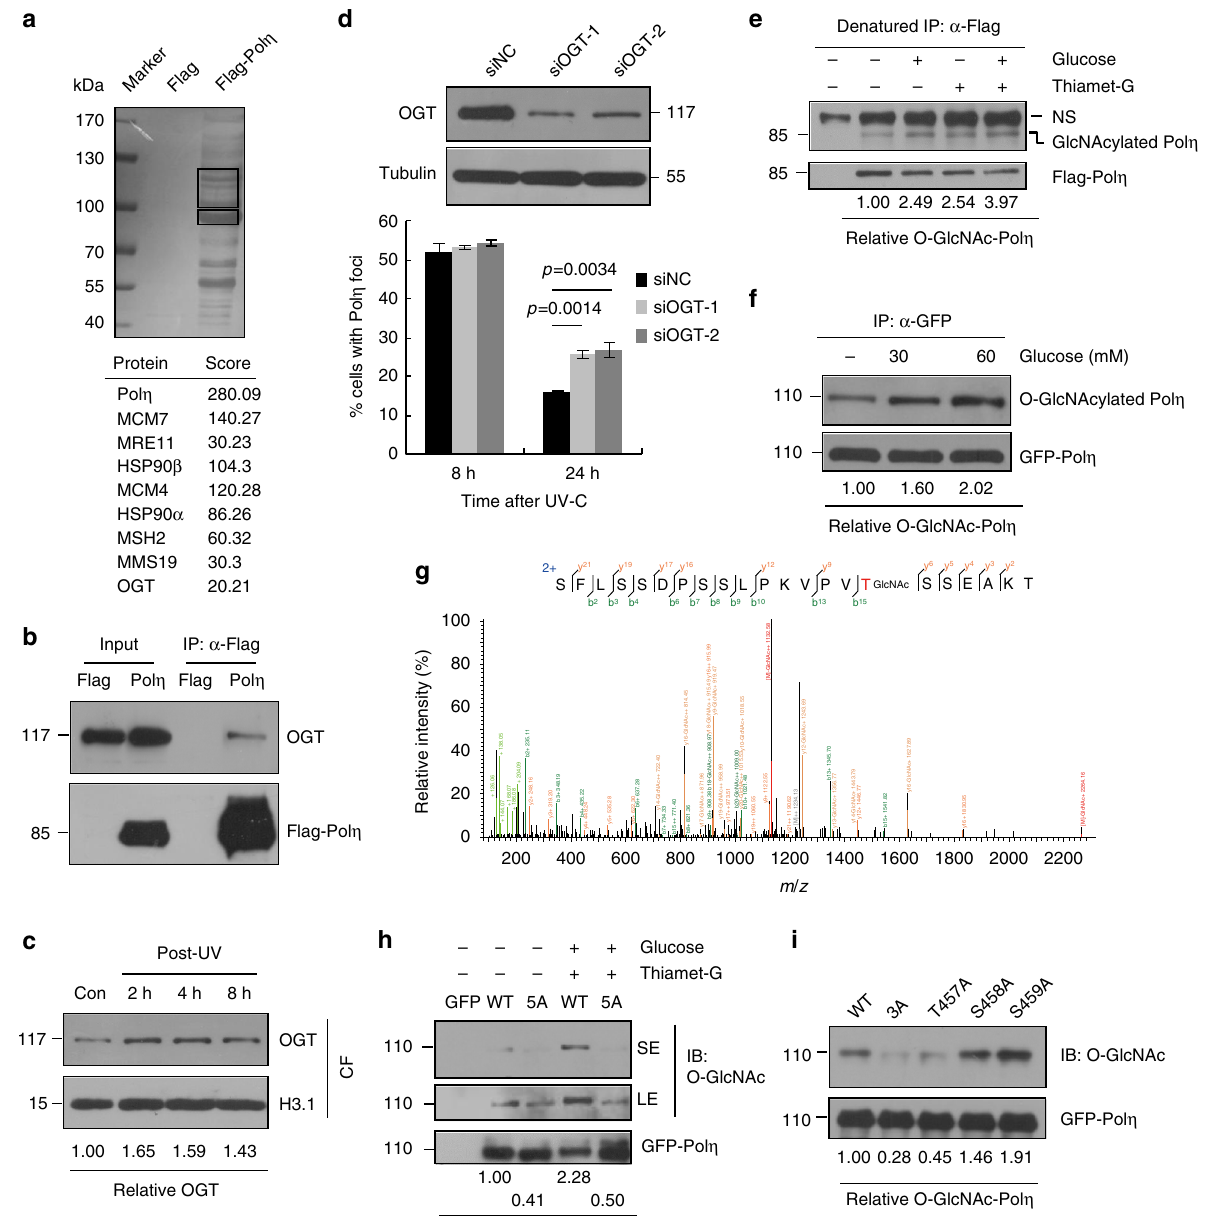
Fig. 1 Pol η interacts with OGT and is subject to O-GlcNAcylation predominantly at T457. a The nuclear extracts of 293T cells expressing Flag-Pol η were immunoprecipitated. The indicated bands (black rectangles) were cut and analyzed via mass spectrometric analysis. b 293T cell lysates expressing Flag-Pol η were immunoprecipitated and detected with anti-OGT and anti-Flag antibodies. The input included 2% of the cell lysate used. c U2OS cells were irradiated with UVC (15 J m − 2 ) and harvested at different time points later. The chromatin fractions were extracted followed by immunoblotting with OGT and H3.1 antibodies. d U2OS cells were transfected with siOGT or siNC oligos. The OGT protein level was detected by western blot. The knockdown cells were transfected with GFP-Pol η , irradiated with UVC (15 J m − 2 ) and further incubated for 24 h. The proportions of GFP-Pol η -expressing cells with > 30 foci were determined. Data represent means ± SEM from three independent experiments. e 293T cells transfected with Flag-Pol η or empty vector were incubated with Thiamet-G and glucose. The cell lysates were denatured and immunoprecipitated with anti-Flag M2 beads followed by immunoblotting with O-GlcNAc and Flag antibodies. NS: non-speci fi c band. f 293T cells transfected with GFP-Pol η were treated with Thiamet-G and different concentrations of glucose. The cell lysates were immunoprecipitated with GFP-Trap A followed by immunoblotting with O-GlcNAc and GFP antibodies. g 293T cells transfected with Flag-Pol η or empty vector were treated with Thiamet-G and glucose. The cell lysates were immunoprecipitated with anti-Flag agarose followed by HCD-MS analysis. The tryptic peptide containing a HexNAc (+203.08 Da) was detected. The b- and y-type product ions were marked on the spectrum and also illustrated along the peptide sequence shown on top of the spectrum. h , i 293T cells transfected with the indicated GFP-Pol η constructs were treated as in g . The cell lysates were immunoprecipitated with GFP-Trap A followed by immunoblotting with O-GlcNAc and GFP antibodies. SE short exposure, LE long